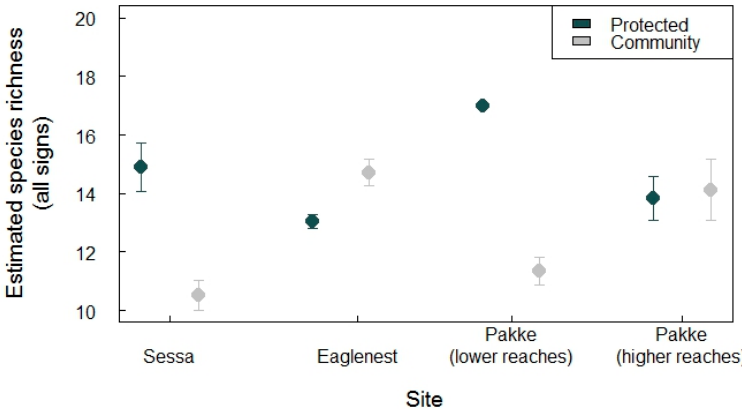
Figure 2. Bootstrapped species richness estimates with standard errors across four independent site comparisons. Pakke Tiger Reserve (lower reaches) had the highest species richness, while the community-managed land adjacent to Sessa had the lowest.